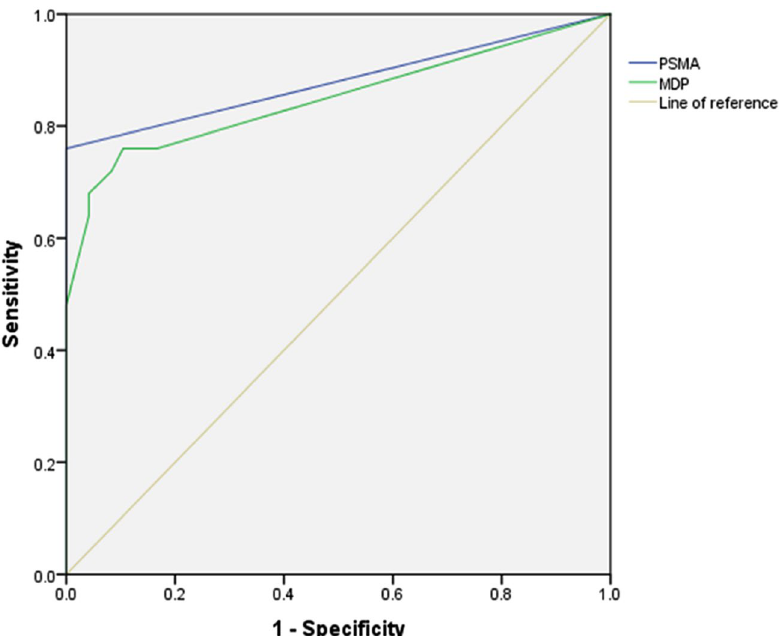
Figure 3. Receiver operating characteristic (ROC) curves for 99m Tc-PSMA SPECT/CT and 99m Tc-MDP SPECT/ CT.